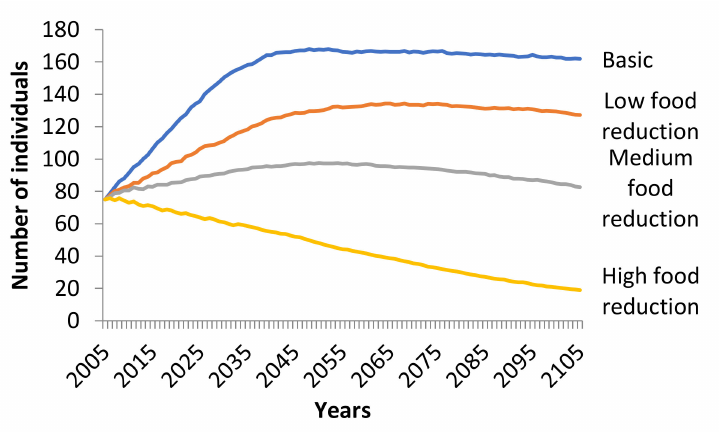
Figure 4. Trend of the Eurasian Black Vulture ( Aegypius monachus ) population, under low, medium and high reduction of supplementary feeding scenarios simulated (100 years) in Southeast